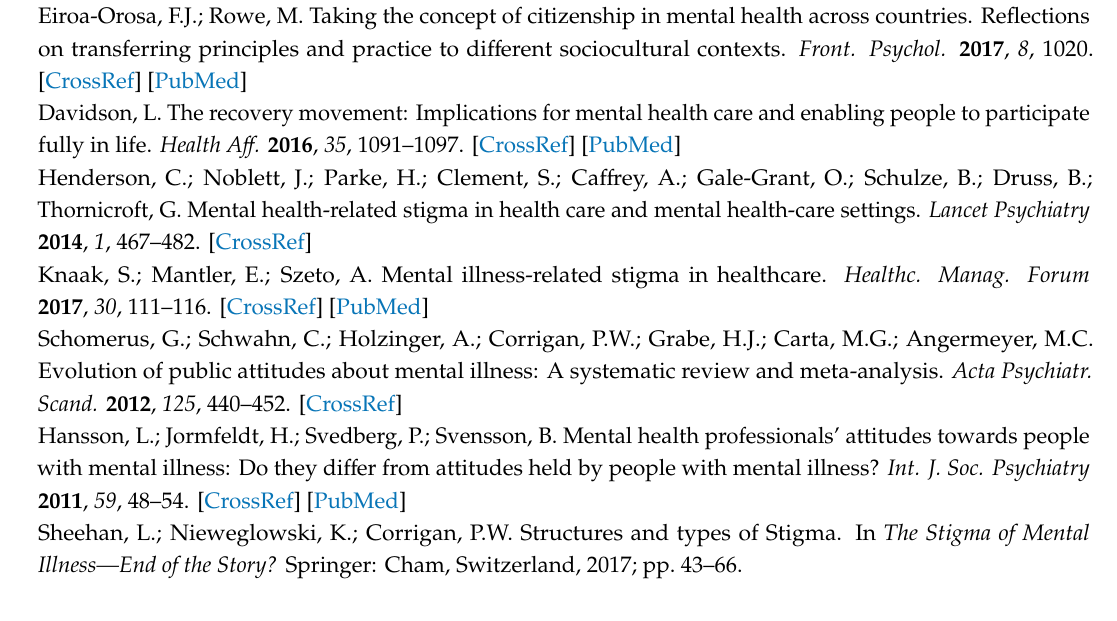
Table S1, Descriptive data of the initial 44 item pool; Table S2, Evolution of confirmatory factor analysis fit and discrimination